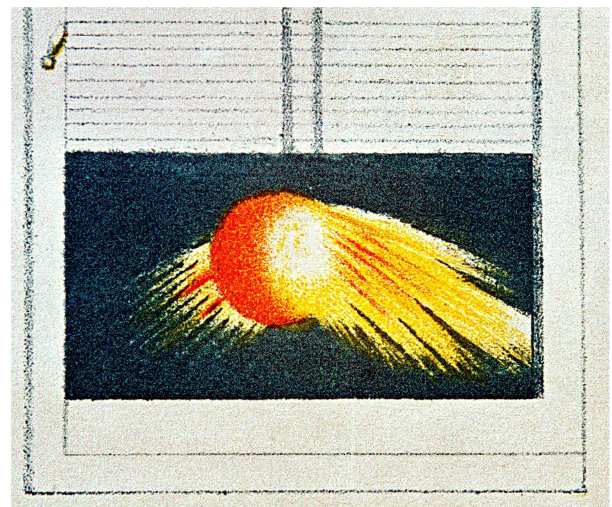
Figure 1. Colour drawing of Haidinger’s object as seen in the win- dow frame; supplement to his 1868 case report to the Imperial Academy of Sciences, Vienna. Reproduction of image detail: Axel